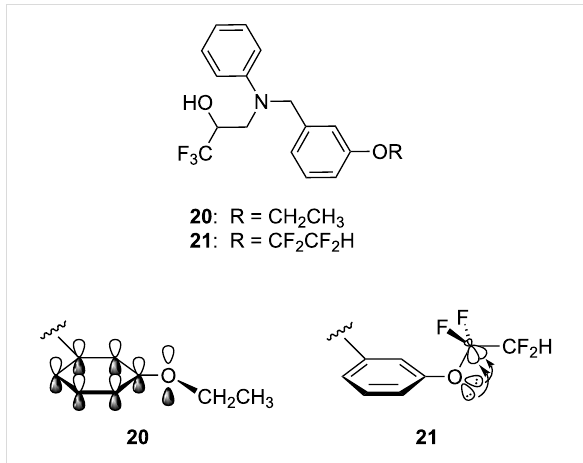
Figure 3: Cholesteryl ester transfer protein inhibitors 20 and 21 . In the fluorinated analogue 21 , n O →σ * CF hyperconjugation leads to an out- of-plane orientation of the fluoroalkyl sidechain, resulting in improved binding affinity.